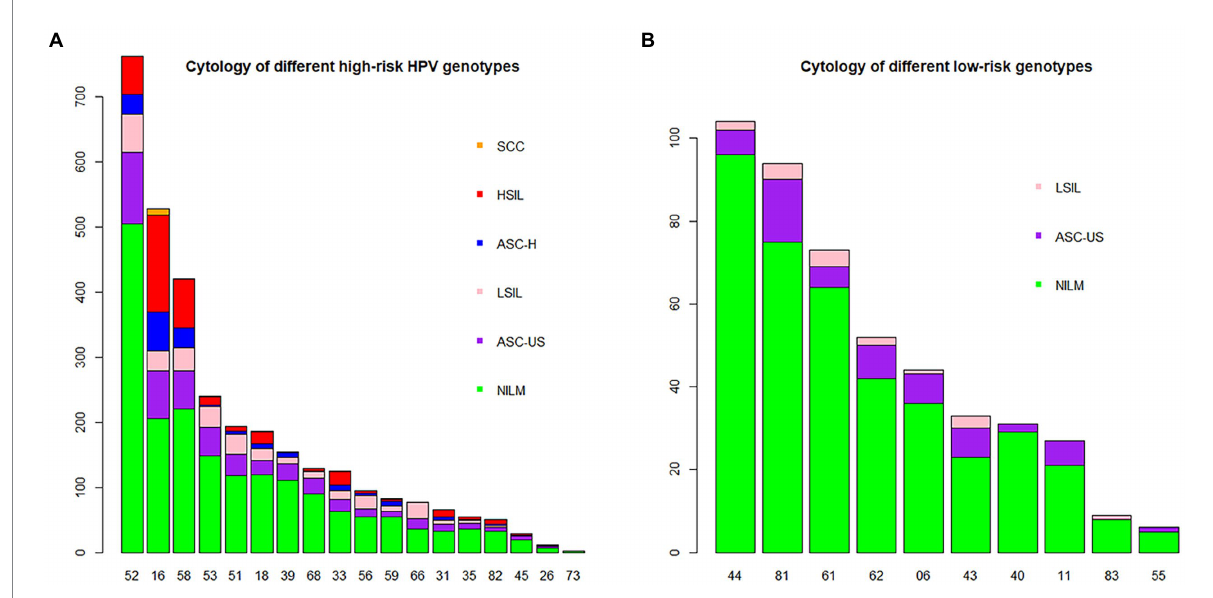
FIGURE 5 HPV genotype infection rates in the NILM, ASC-US, LSIL, ASC-H, HSIL and SCC groups. Each bar represents the number of infections due to corresponding HPV genotypes. Green, violet, pink, blue, red and yellow represent the numbers of NILM, ASC-US, LSIL, ASC-H, HSIL and SCC cases attributable to the corresponding genotype, respectively. (A) High-risk HPV genotypes with cytological results. (B) Low-risk HPV genotypes with cytological